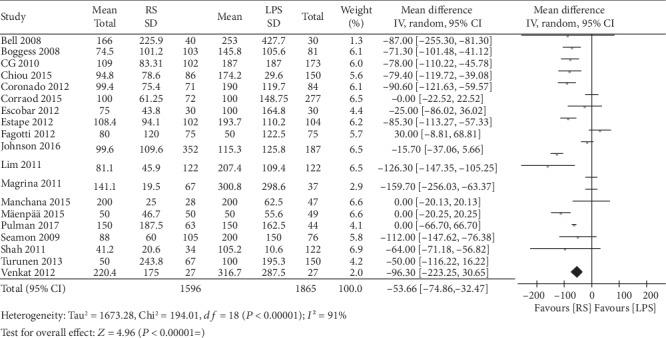
Forest plot of the EBL between the RS and LPS groups.